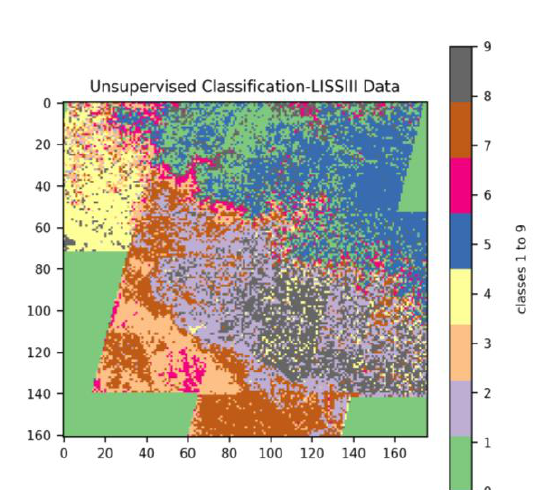
Figure 18. MiniBatchKMeans unsupervised